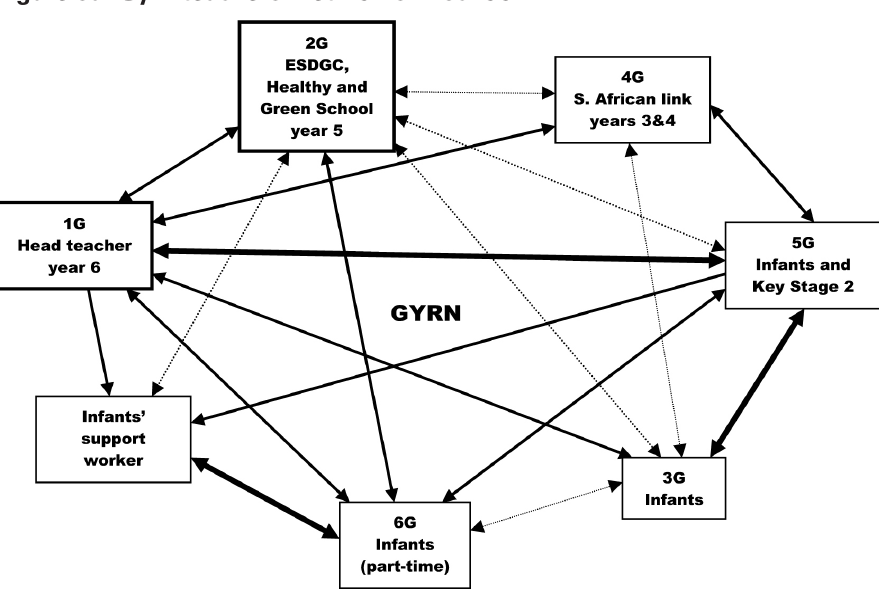
Figure 3a: Gyrn teachers’ networks in